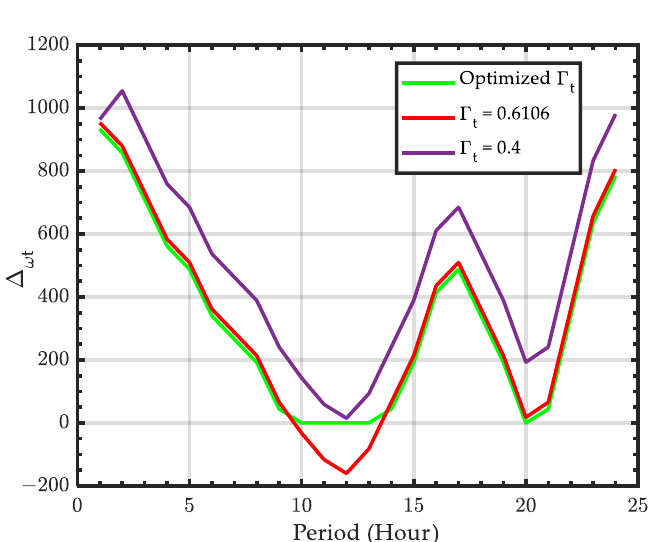
Figure 8. Optimal schedule of thermal units and WP source for case 4.